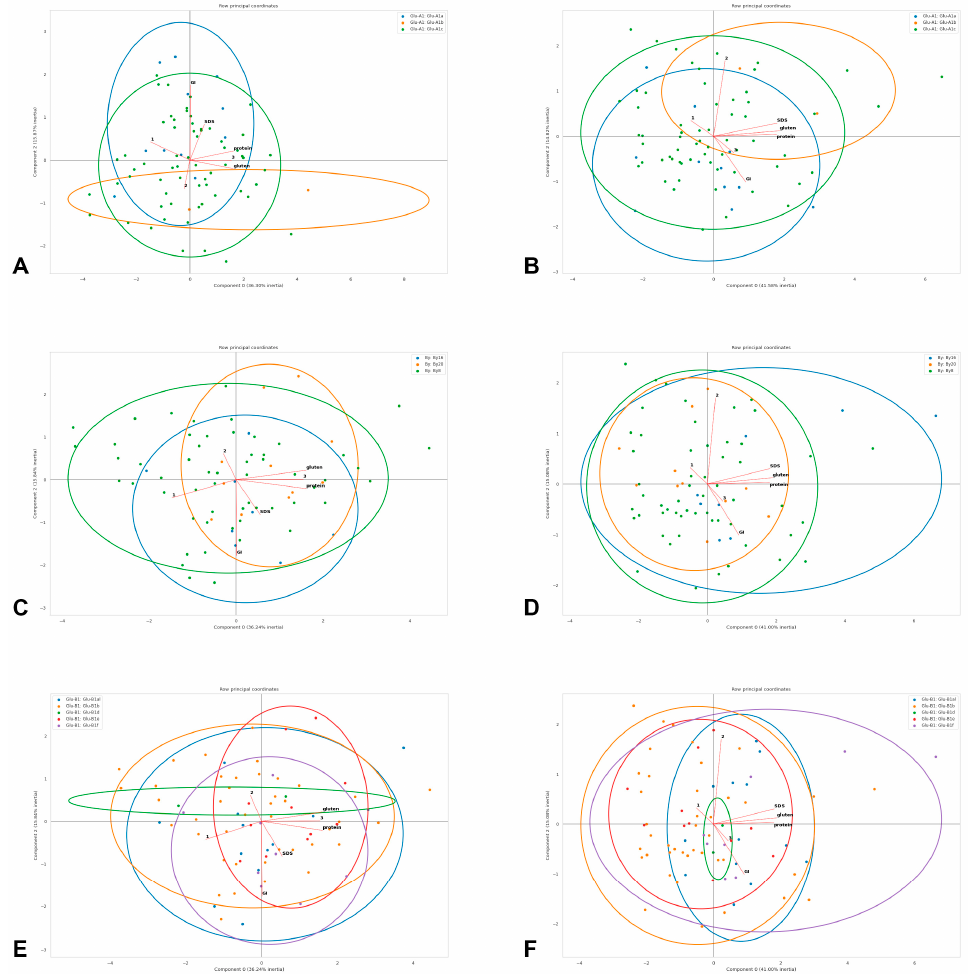
Figure 4. Principal component analysis of quality traits in the studied winter durum wheat accessions with different Glu-A1 ( A , B ), By ( C , D ) and Glu-B1 ( E , F ) genotypes estimated in 2019–2020 ( A , C , E ) and 2020–2021 ( B , D , F ): protein—protein content (logit-transformed data); gluten—gluten content (logit-transformed data); GI—gluten index (logit-transformed data); SDS—SDS sedimentation volume; 1—volume increase index; 2—breaking strength; 3—general estimation of pasta. Genotypes are shown with dots of different colours deciphered in the upper frame in each diagram.